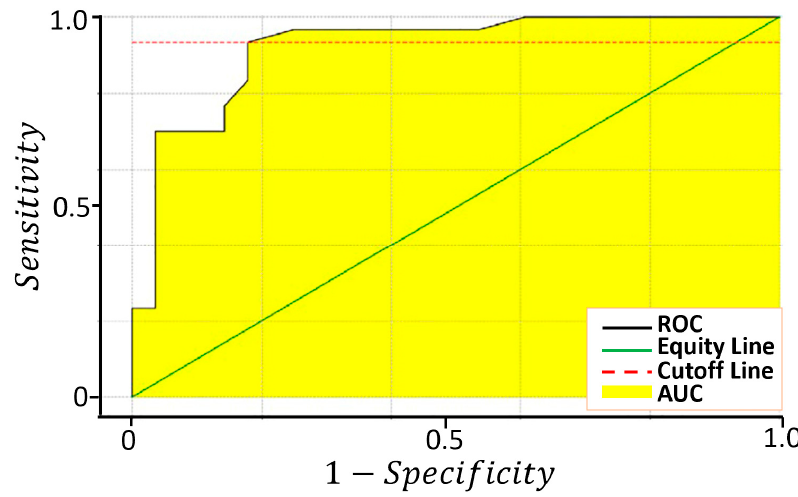
Figure 9. Evaluation of the sensitivity and specificity of the device in discriminating between T1 and T4 samples. ROC curve calculated on the PC1 projected dataset resulting from 1000 iterations.